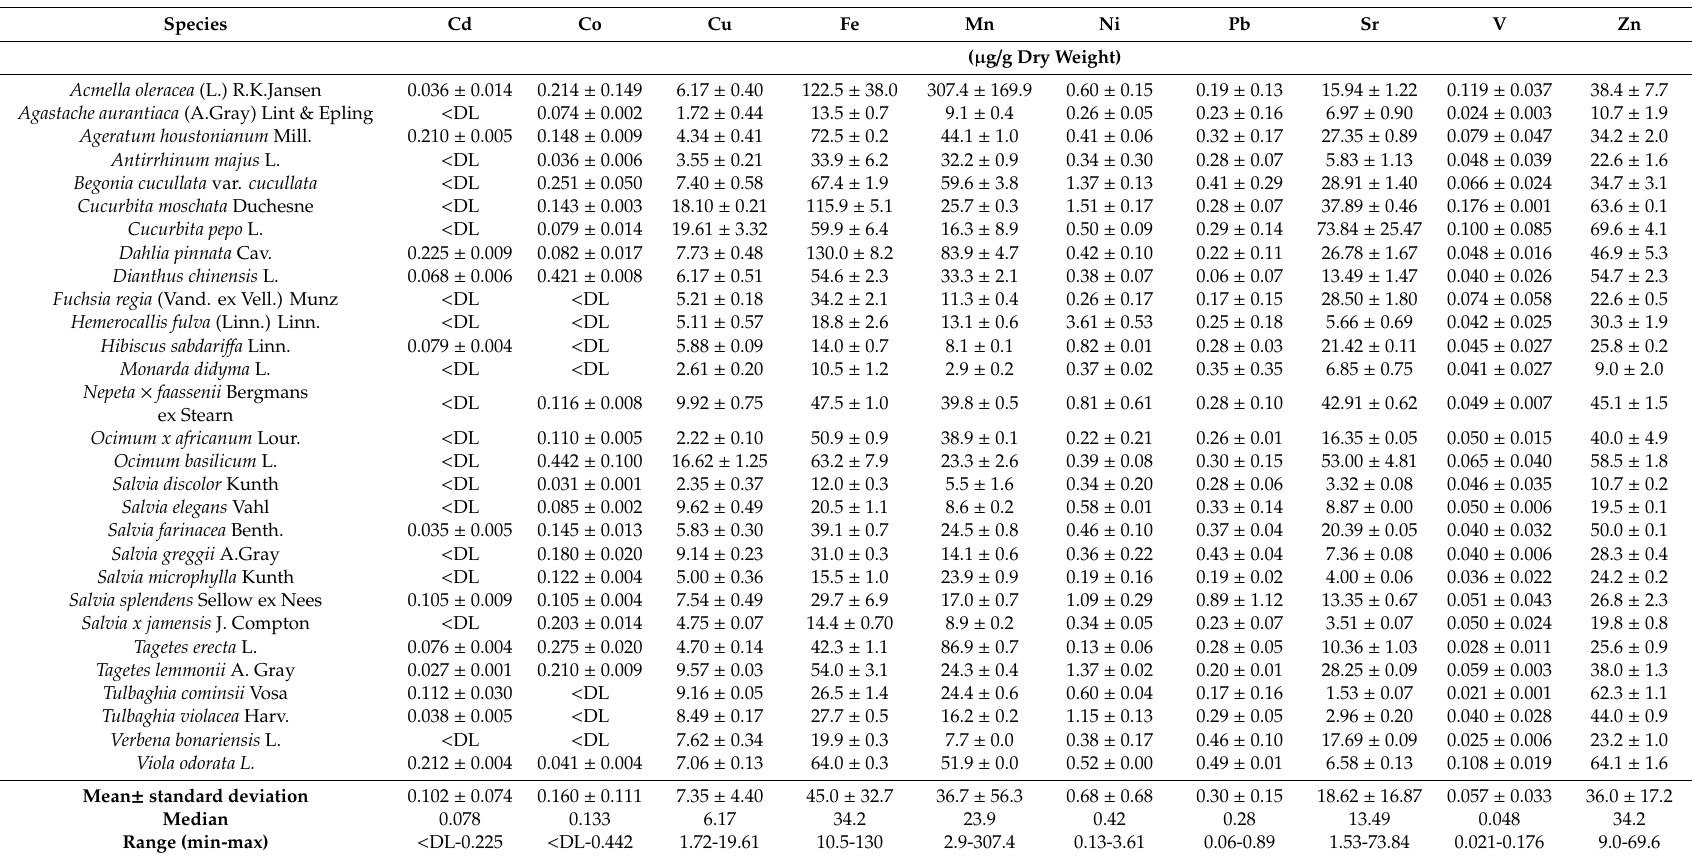
Table 1. Concentrations (expressed as µ g / g dry weight) of 10 trace elements in edible flowers belonging to 29 species. Data are reported as mean value ± standard deviation. Summary statistics (mean ± standard deviation, median and range) referred to the whole data set are also